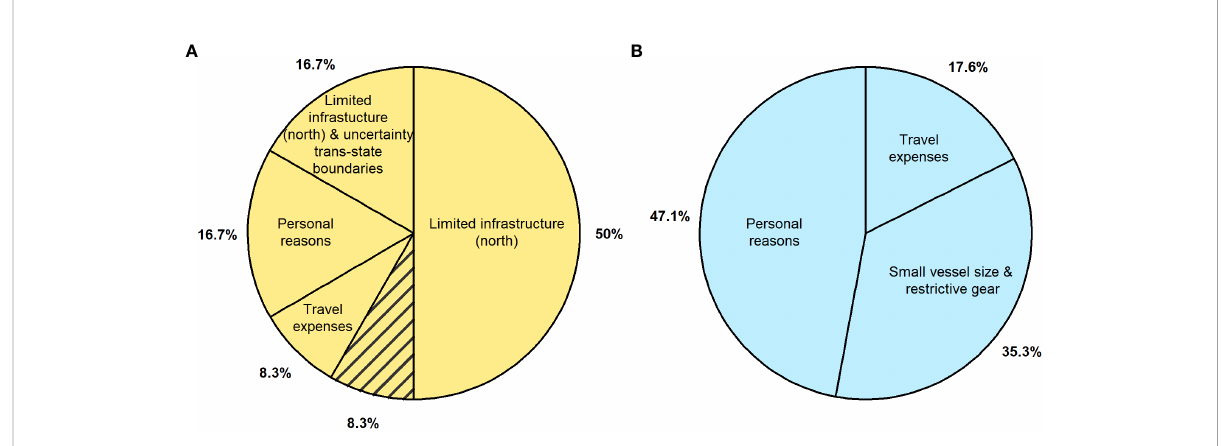
FIGURE 7 Themes from open-ended responses from fi shermen who chose to elaborate on travel/mobility-related constraints to adaptive capacity. (A) indicates the percent of responses from market squid fi shermen who chose to elaborate (n=11) and (B) indicates the percent of responses from spiny lobster fi shermen who chose to elaborate (n=17). Each theme is labeled in the pie chart and hashing indicates overlap between two adjacent themes. Note that half of fi shermen cited limited infrastructure in northern regions alone and an additional 16.7% cited that along with uncertainty in trans-state fi shery boundaries (e.g., Oregon, Washington,